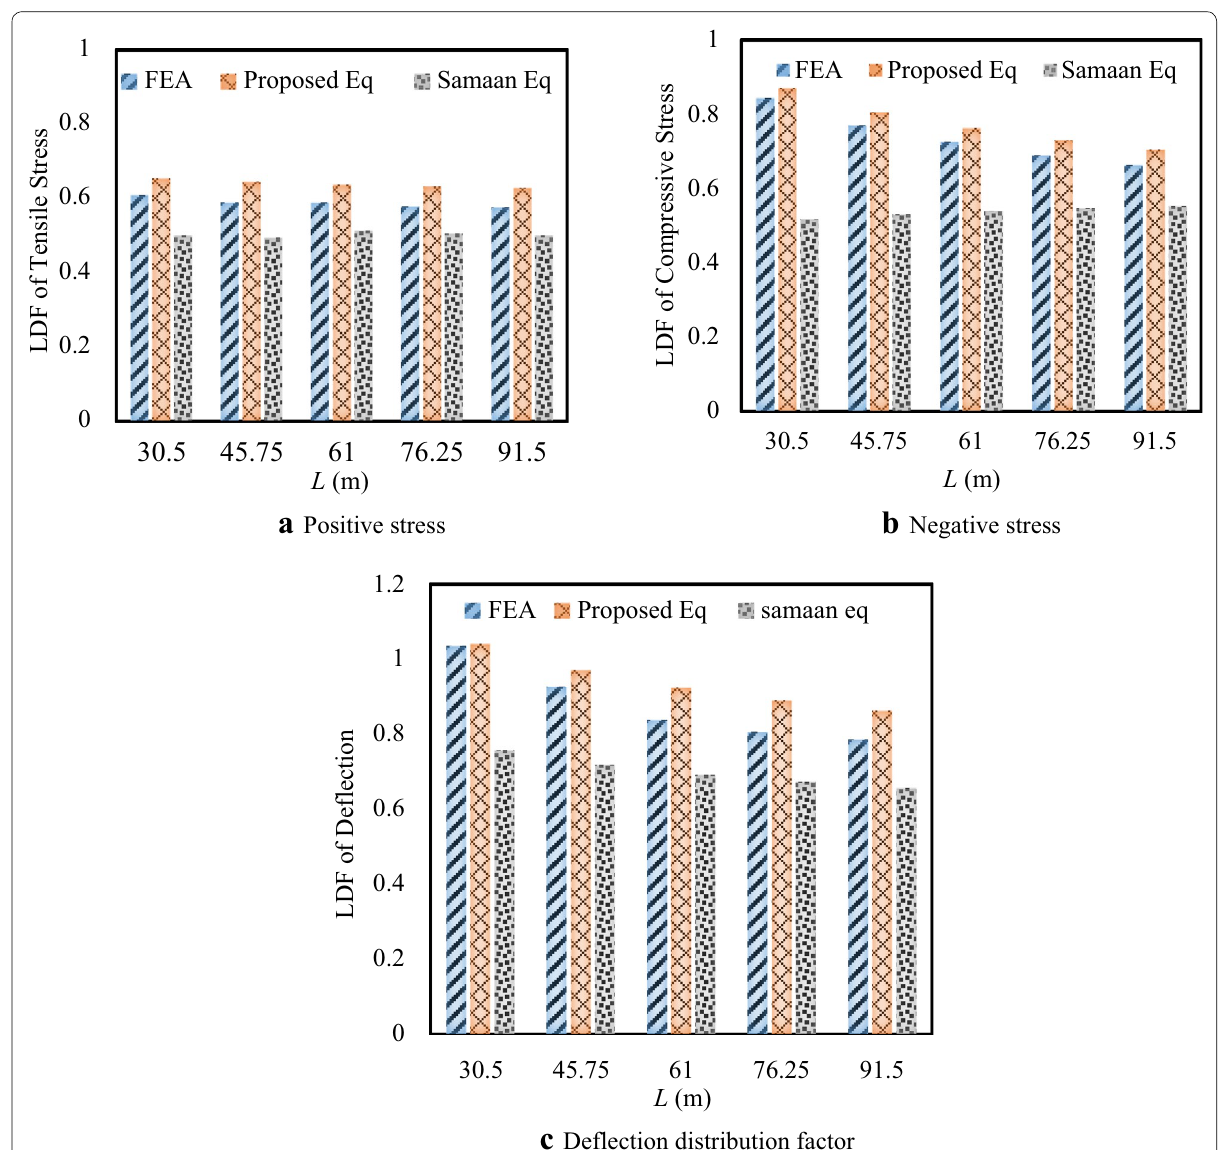
Fig. 15 Comparison of the DF s.